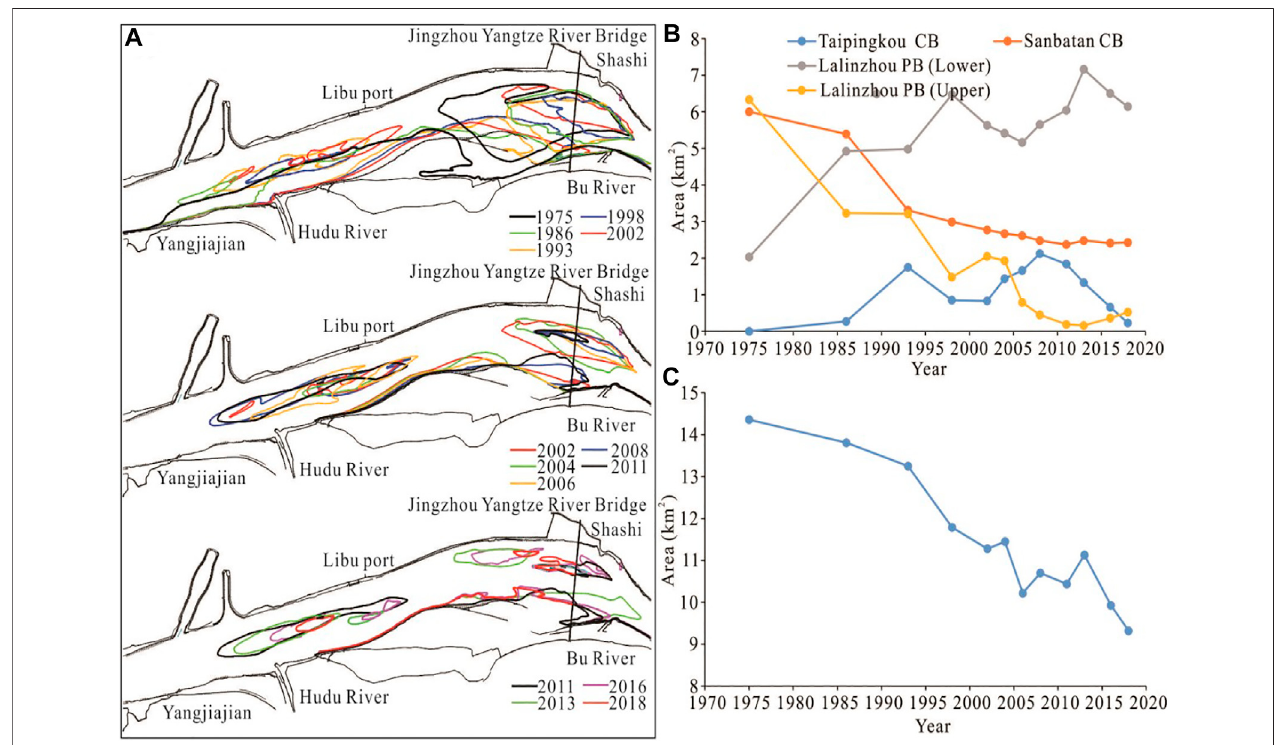
FIGURE 11 | Shape and area of beach; (A) Beach evolution process; (B) Beach and Central bars area changes; (C and D) area variation.